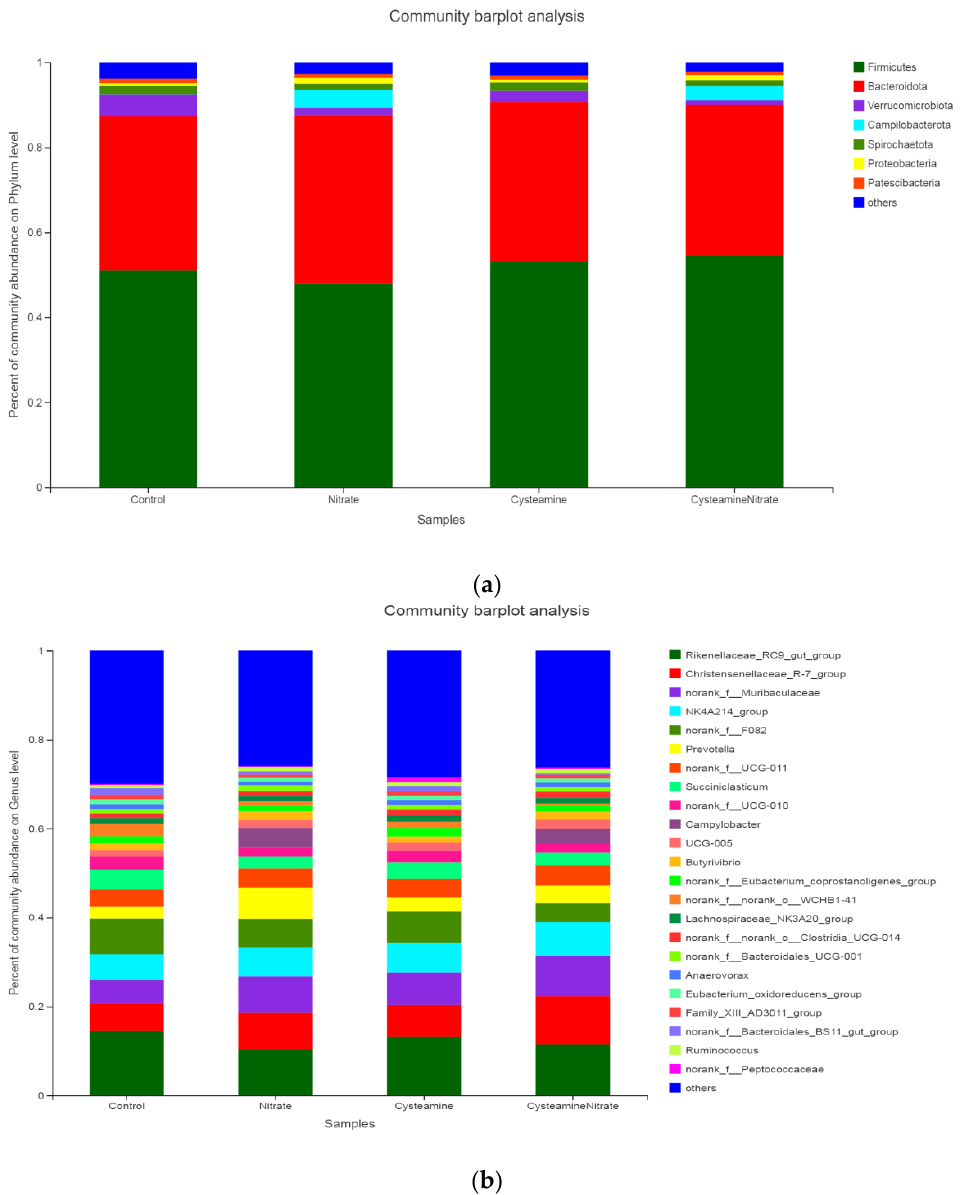
Figure 4. Relative abundance of rumen microflora of buffalo at phylum level ( a ) and genus level ( b ).